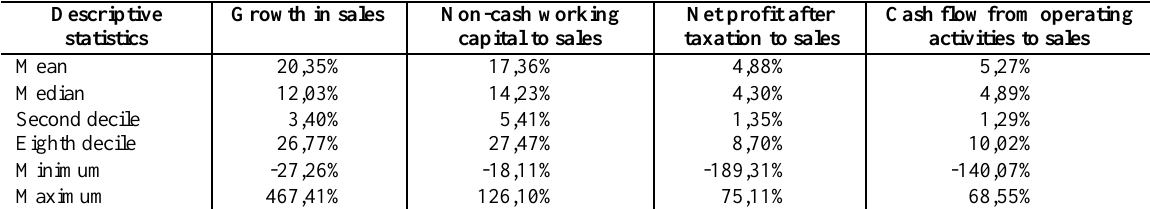
Table 2: Descriptive statistics of the